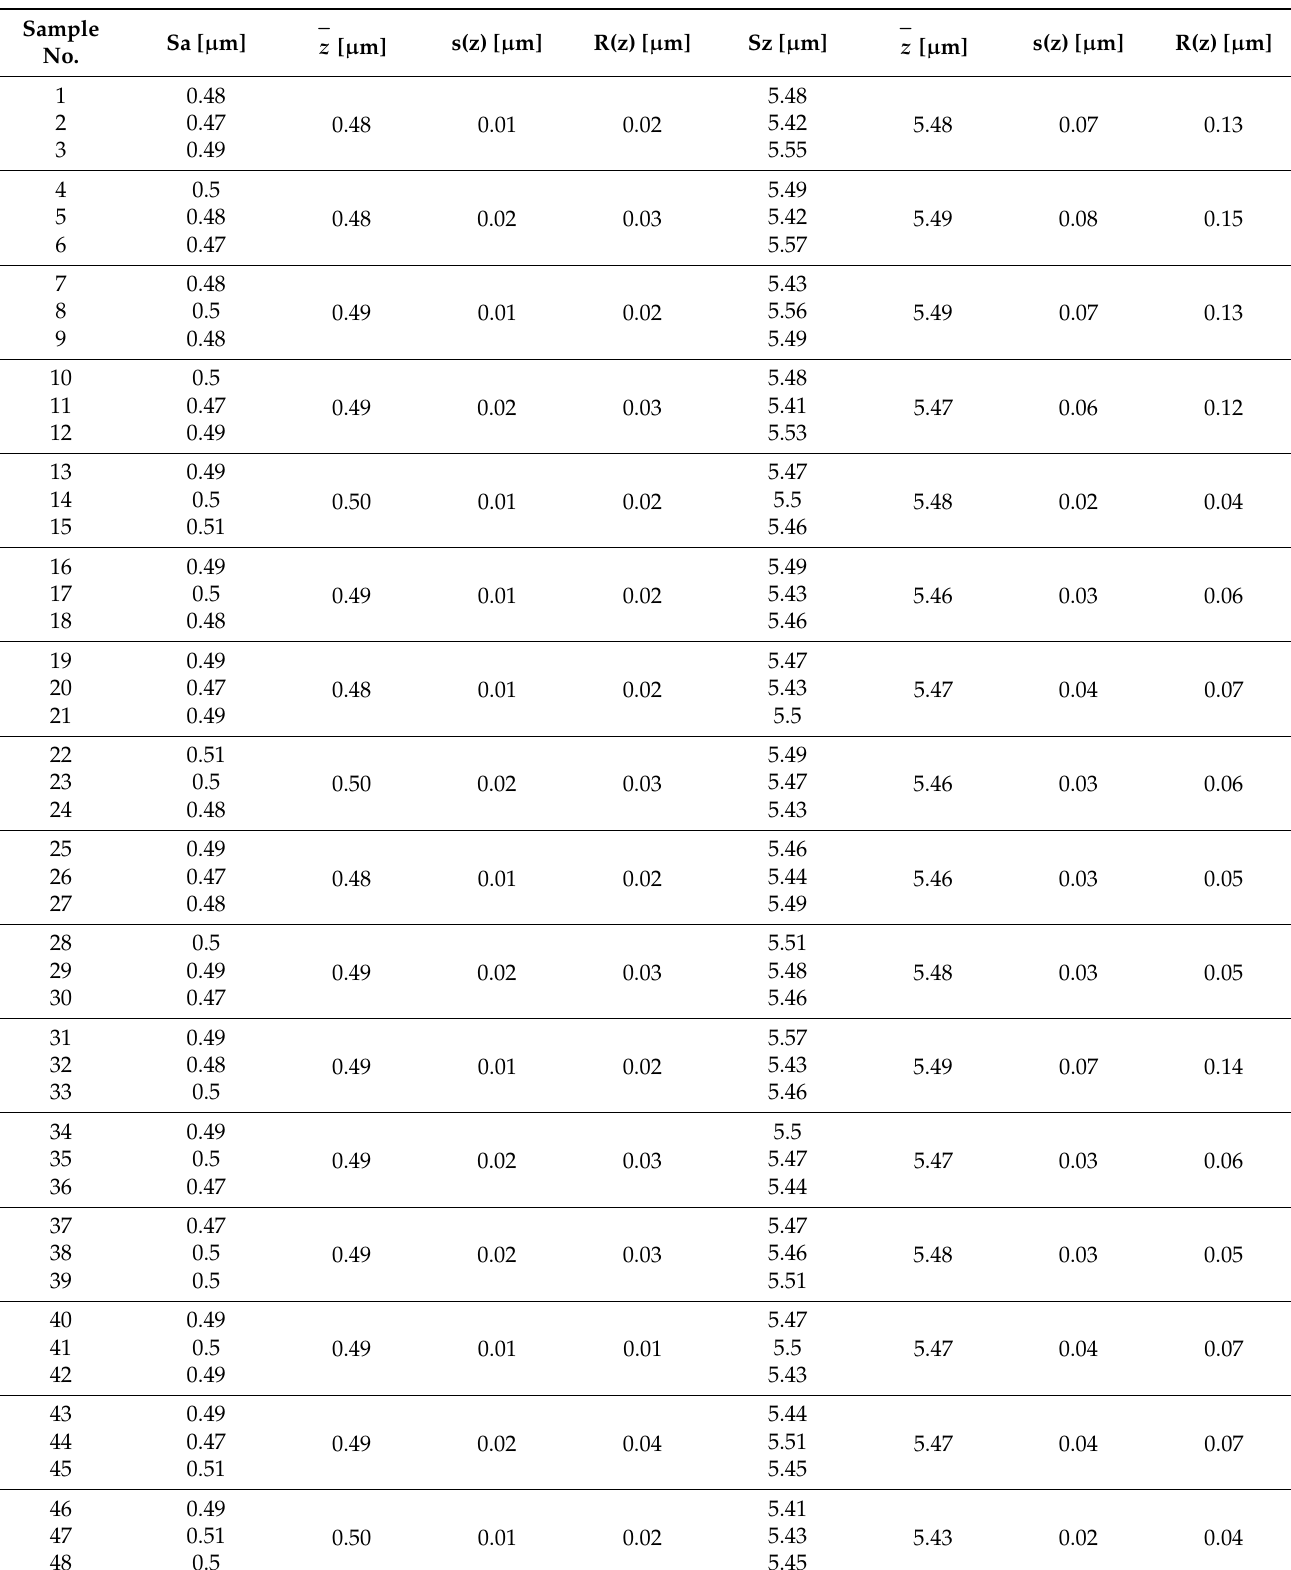
Table 10. Sa and Sz measurement results of polymethyl methacrylate PMMA samples before paint